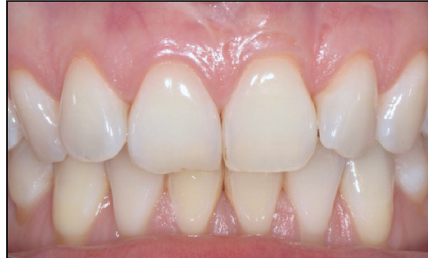
Figure 8: Clinical conditions 15 years after the surgical